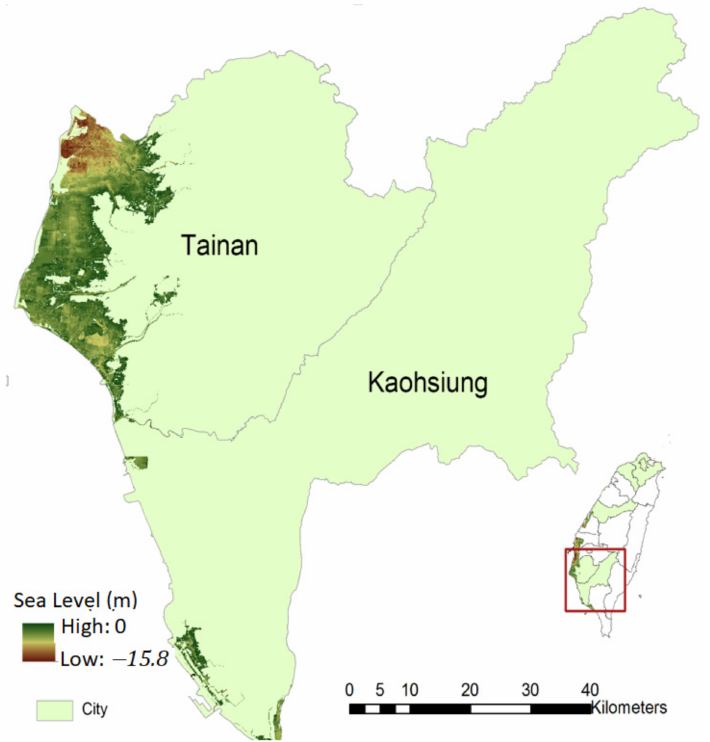
Figure 10. The 100-year flood map of Tainan under combined situations of vertical land motions (VLM), extreme SLR, and highest astronomical tide